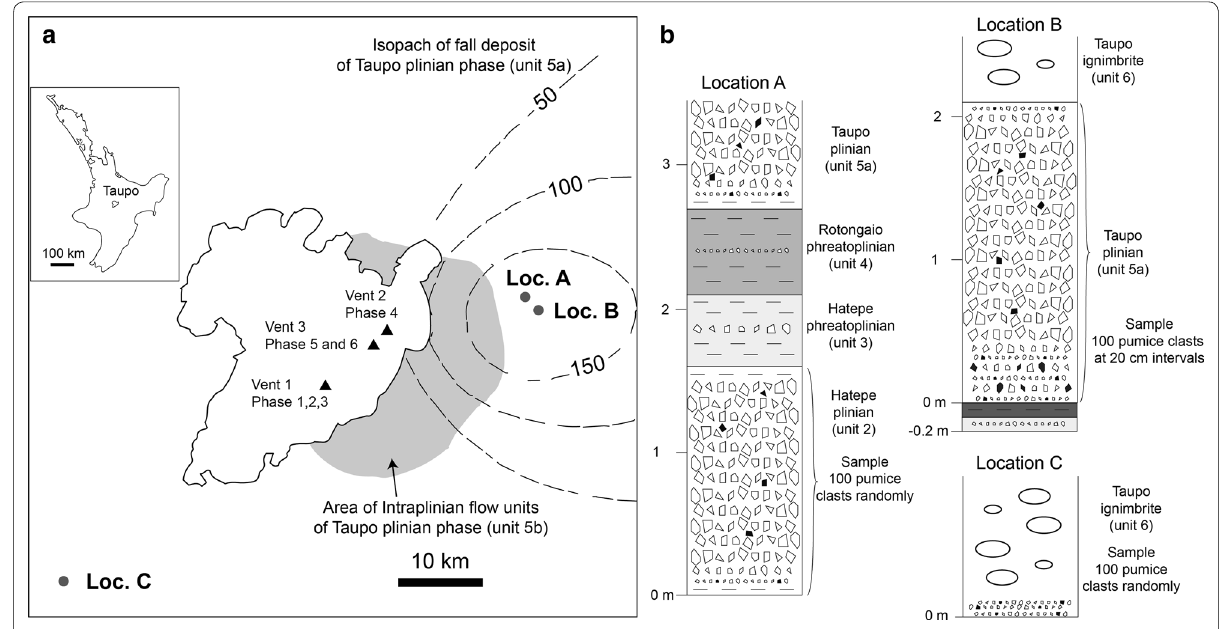
Fig. 1 Location map and stratigraphic logs. a The locations of sampling at Taupo volcano, New Zealand, with the vent positions of the 232 AD eruption after Smith and Houghton (1995). Location A, B, and C are outcrops where we collected samples of Hatepe plinian fall deposit (unit 2), Taupo plinian fall deposit (unit 5a), and Taupo ignimbrite (unit 6), respectively. The isopach of fall deposit of Taupo plinian fall deposit (unit 5a) is from Walker (1980). The values are in centimeters. The area of intra-plinian flow units of Taupo plinian phase (unit 5b) is from Wilson and Walker (1985). b Stratigraphic logs for location A, B, and C. Pumice clasts shown as open symbols; wall rock clasts as closed symbols; fine ash as dashed